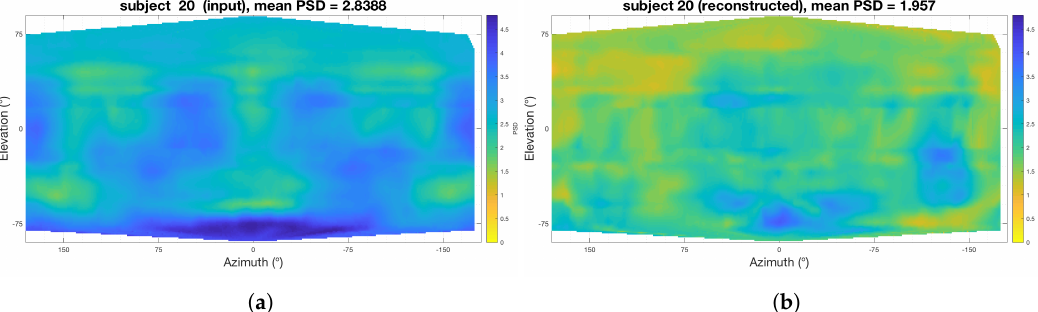
Figure 15. Comparing the PSD of Subject 20 from SADIE II database before and after reconstruction, which shows a noticeable improvement in most regions. ( a ) Before Reconstruction. ( b ) After